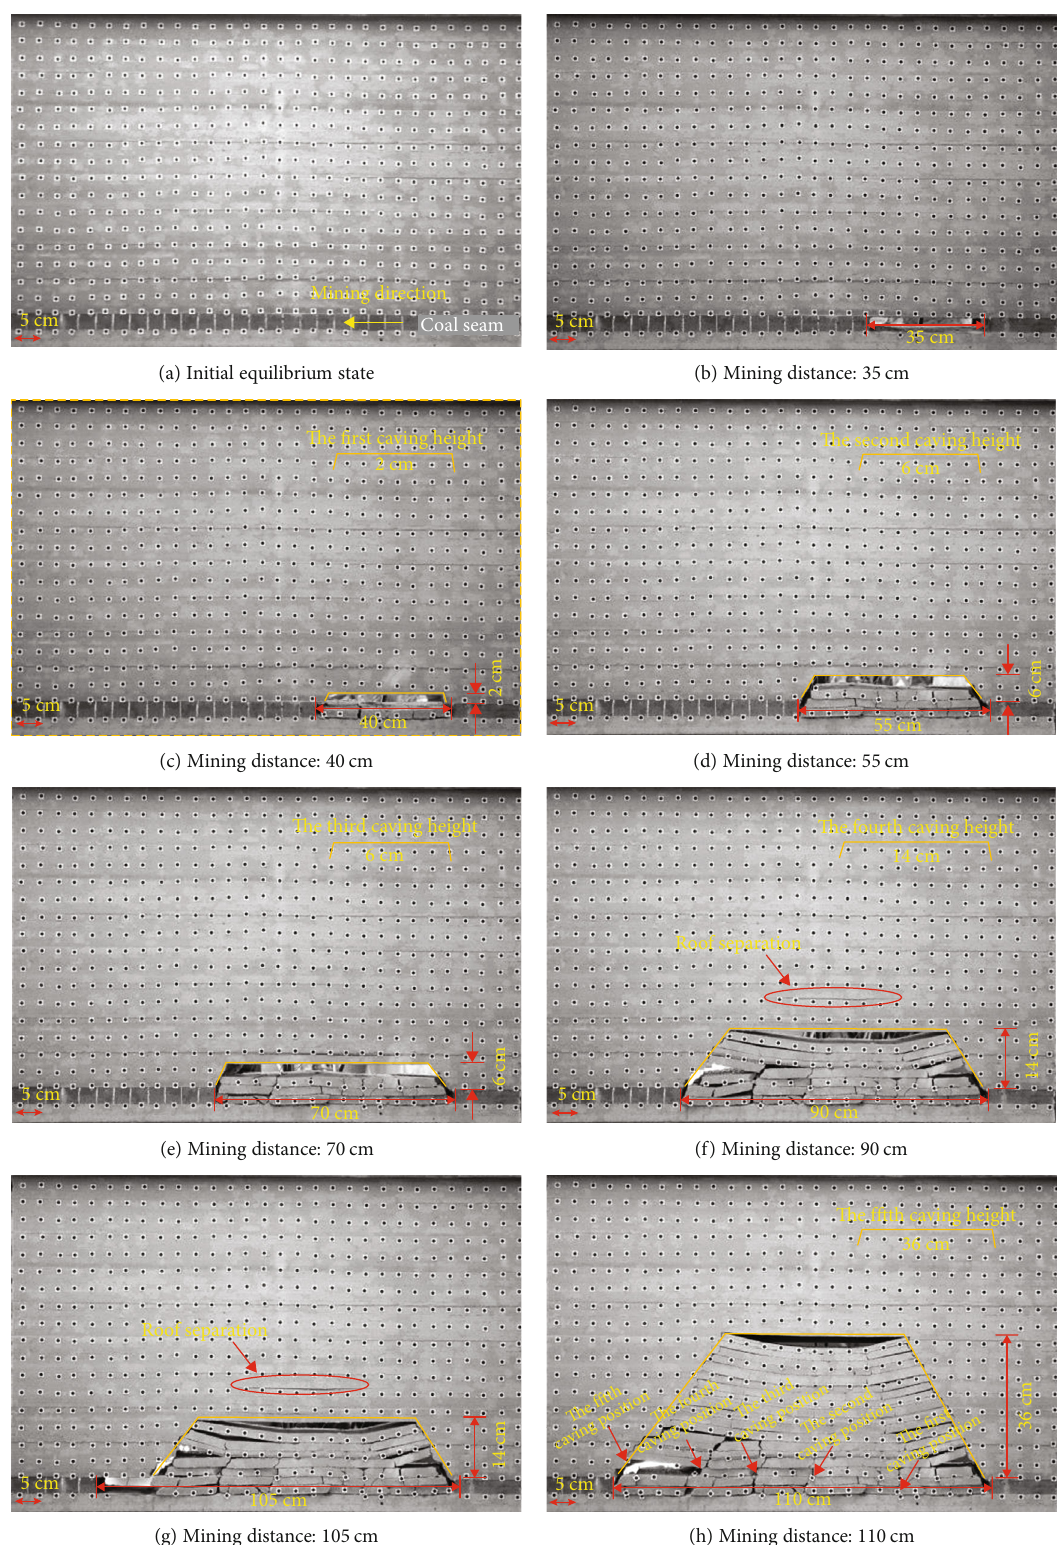
Figure 3: The movement state of the roof during coal seam mining in the physical